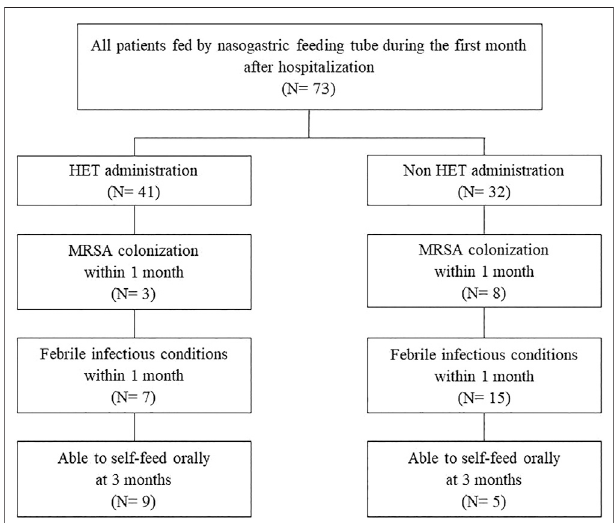
FIGURE 1 | Flowchart depicting the study